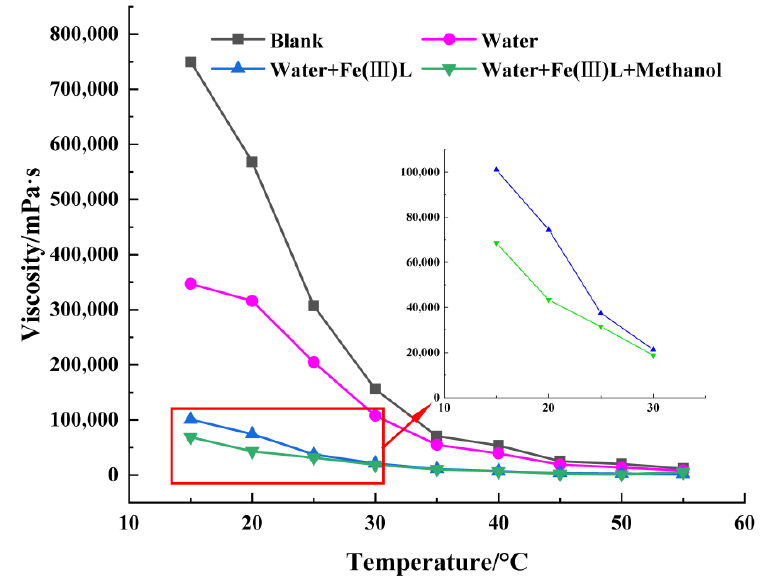
Figure 5. Effects of methanol on the viscosity of the oil sample.